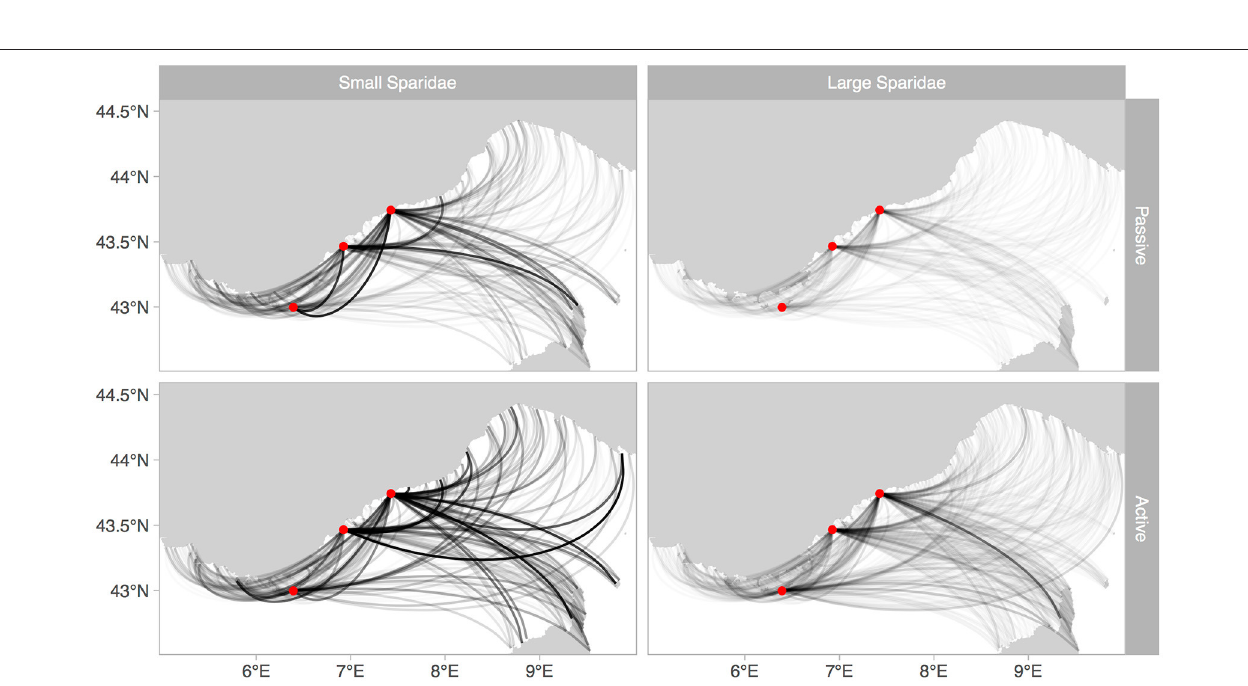
FIGURE 7 | Connectivity patterns throughout the Ligurian Sea, from the three release MPA (red dots). Lines represent connections, not dispersal trajectories. Their intensity is proportional to the intensity of the connections.